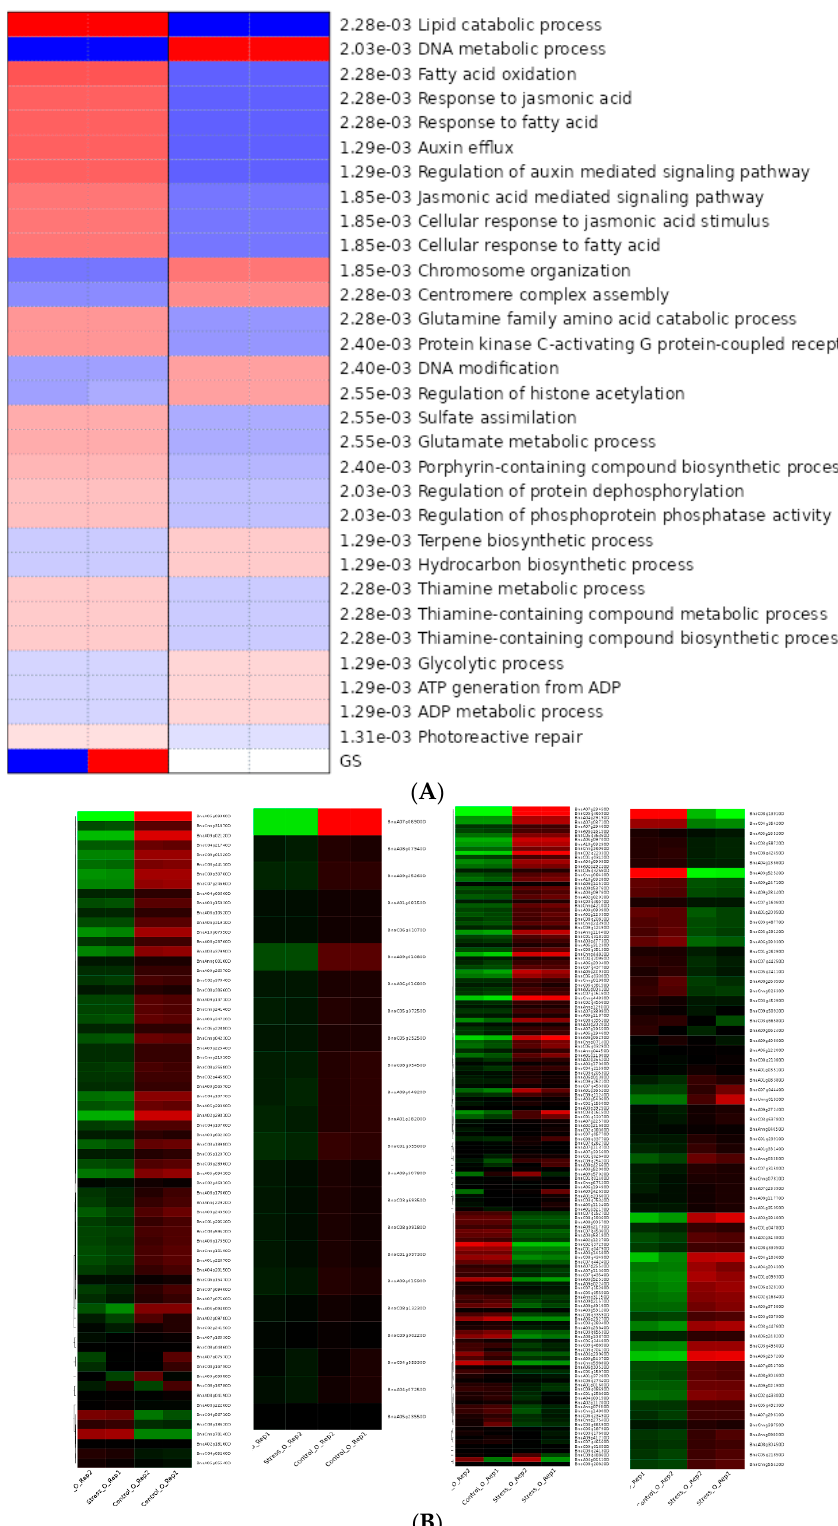
Figure 7. KEGG expression profiles of DEGs using PGSEA. ( A ) KEGG terms associated with biological functions of DEGs using PGSEA; ( B ) list of genes up-regulated or down-regulated associated with PSII, PSI, and peroxidase jasmonate signaling. Red and green indicate up-regulated and down- regulated genes, respectively.